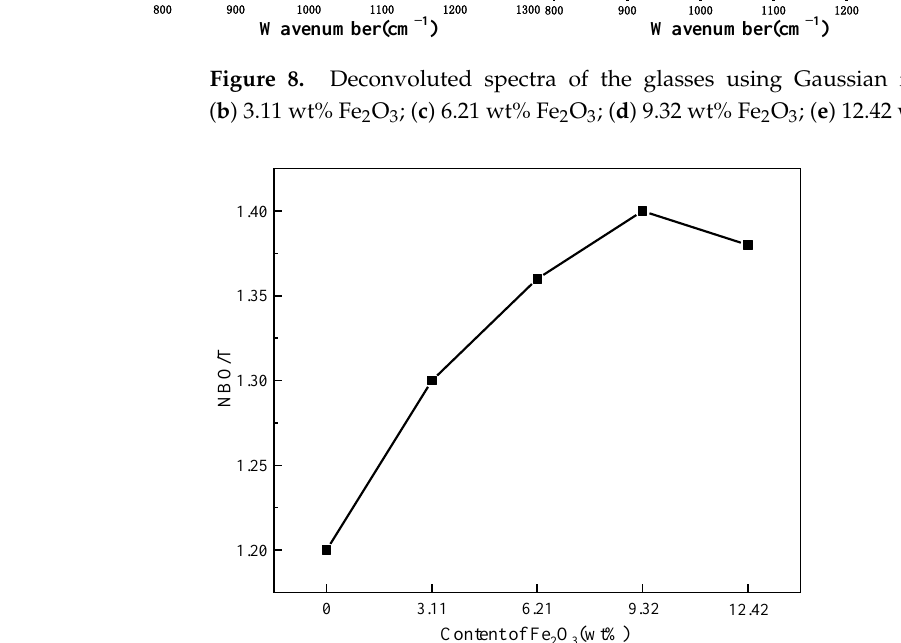
Figure 9. NBO/T as a function of Fe 2 O 3 content. The increase in Fe 2 O 3 to 9.32 wt% promotes the reaction to the left, leading to the conversion of bridging oxygen to non-bridging oxygen in the glass. The Fe 2 O 3 content has a strong depolymerizing effect on the glass network, which makes the structure loose. This change forms more ion channels, making it easier for isolated ions such as Mg 2+ and Fe 3+ , which have smaller ionic radii, to diffuse in the melt. Thus, the precipitation of the anorthite and ferrobustamite phase is promoted. By further increasing Fe 2 O 3 , the reaction proceeds to the right, which means that non-bridging oxygen is converted to bridging oxygen [30]. The transition reveals that Fe 2 O 3 can not only promote the depolymerization of the glass structure but also polymerize to some extent. The loose glass network structure always favors the nucleation of the precursor [31]. Therefore, Fe 2 O 3 can promote the depolymerization of glass network structure and drive the precipitation of the anorthite and ferrobustamite phase from the glass phase. However, the nucleation of the glass- ceramics is likely to be inhibited with high Fe 2 O 3